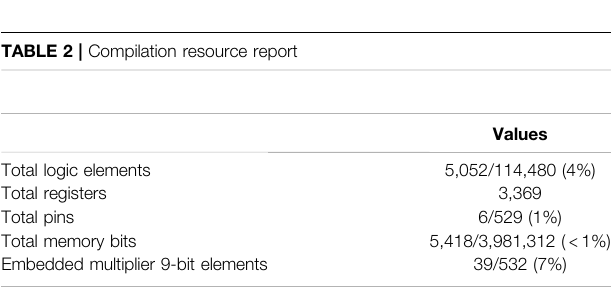
TABLE 2 | Compilation resource report